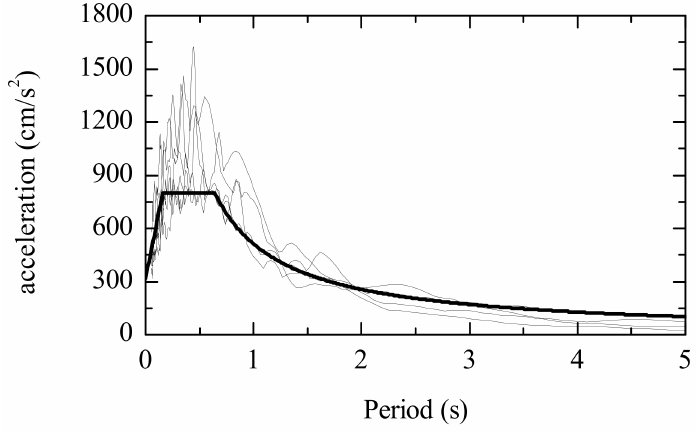
Figure 10. Response spectra of selected ground motions and design response spectrum of Level-2 earthquake with 5% damping factor.